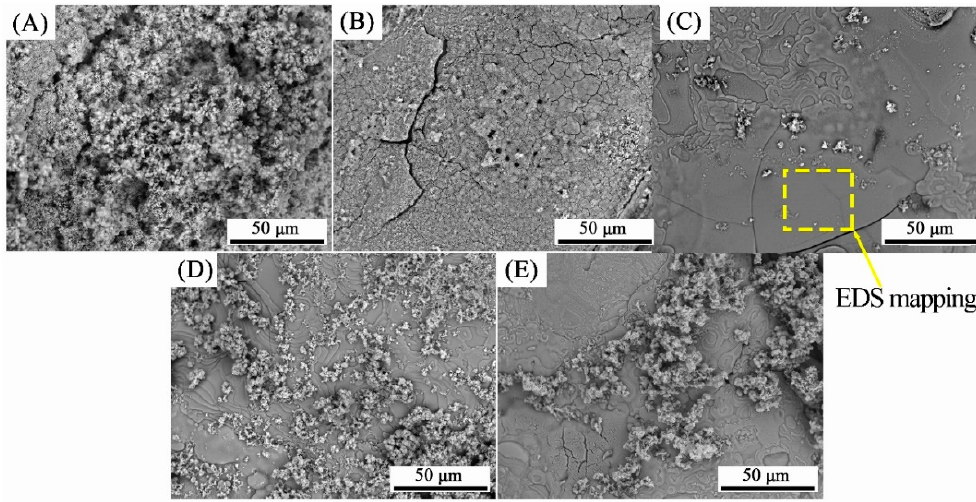
Figure 2. Surface morphology of HA coating on PVA/PLA braids with deposition time of ( A ) 60, ( B ) 75, ( C ) 90, ( D ) 105, and ( E ) 120 min.